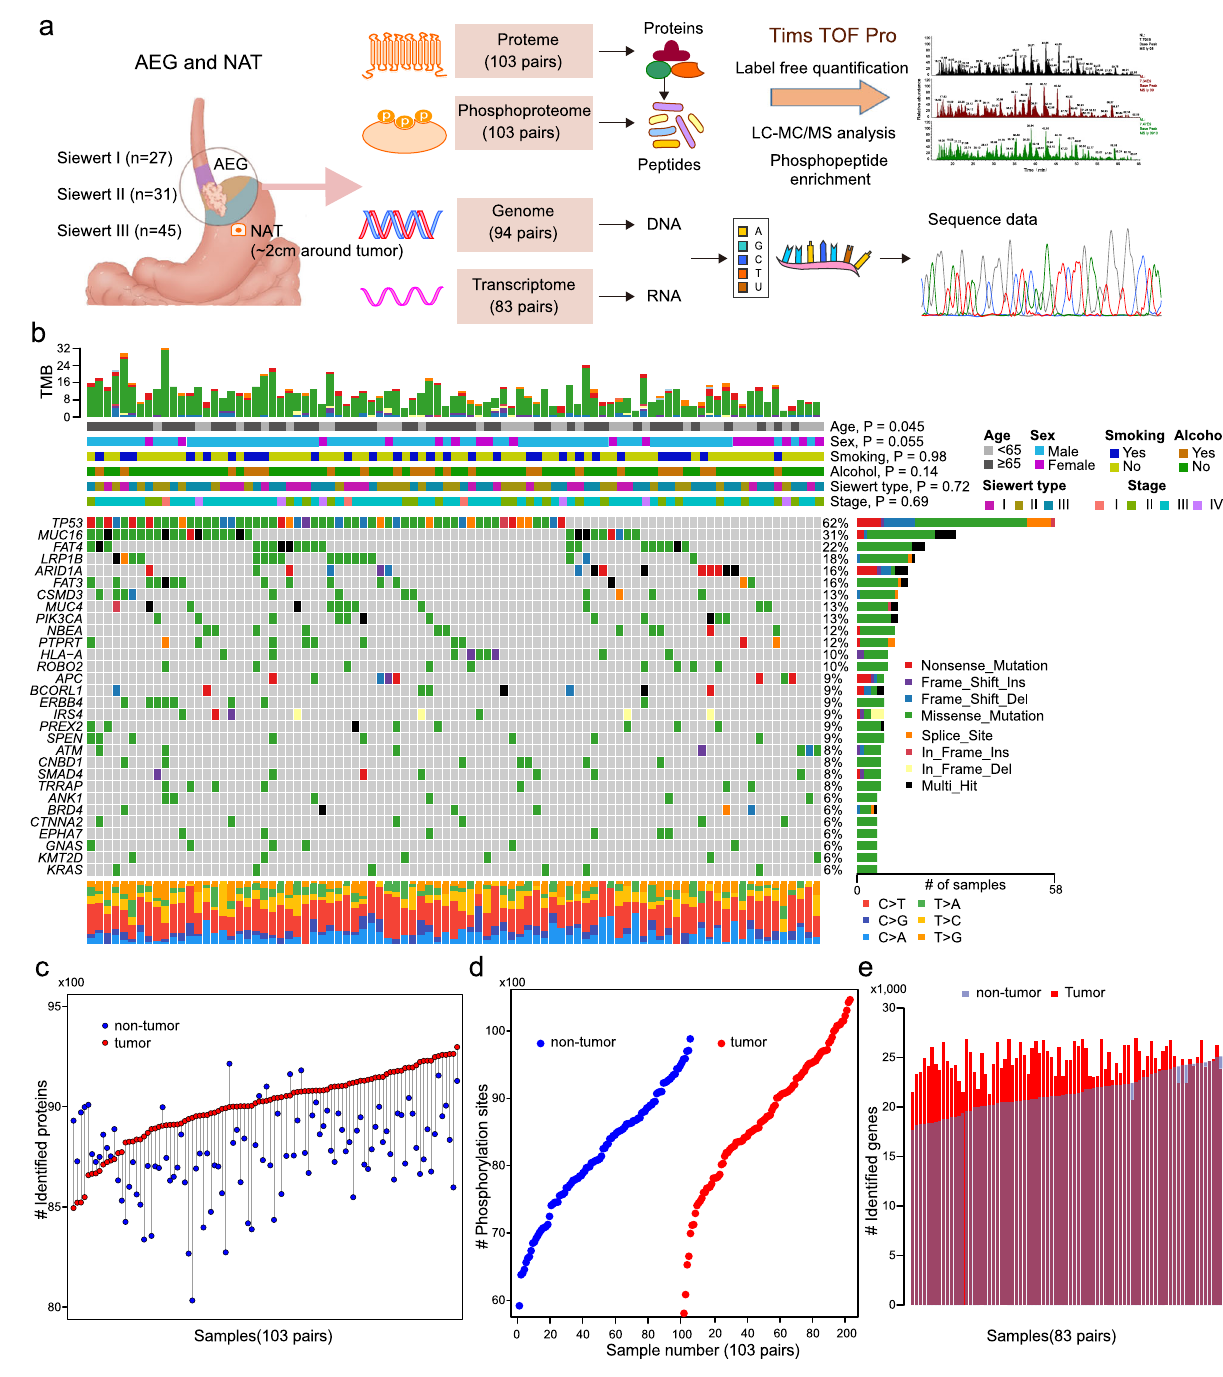
Fig. 1 | Multi-omics landscape of adenocarcinoma of the esophagogastric junction (AEG). a Schematic overview of the experimental design and data acquisition process for proteomics, phosphoproteomics, WES, and RNA-seq. NAT indicates normal adjacent tissue. b The genomic pro fi les of AEG patients. The top panelshows the tumor mutation burden (TMB)in each patient. The topbars show the clinicopathological features of AEG patients. The middle panel is the oncoplot generated with maftoolsdepicting the top 30 mutated cancer-related genes in the